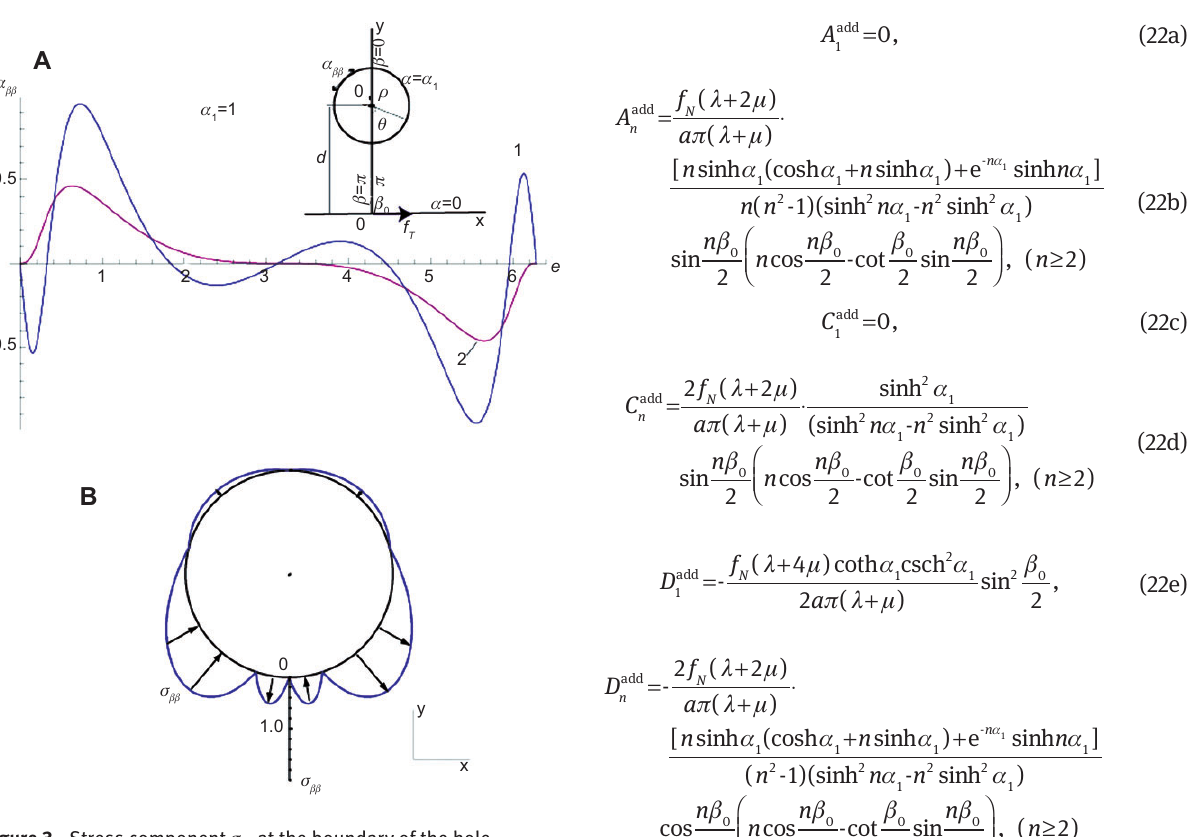
Figure 3 Stress component σ at the boundary of the hole. β β (A) Stress component σ as a function of the polar angle θ associ- β β ated with the hole. Stresses are given for the boundary of the hole = 1 (1), which corresponds to the aspect ratio with coordinate α 1 d δ = 1.54. ρ